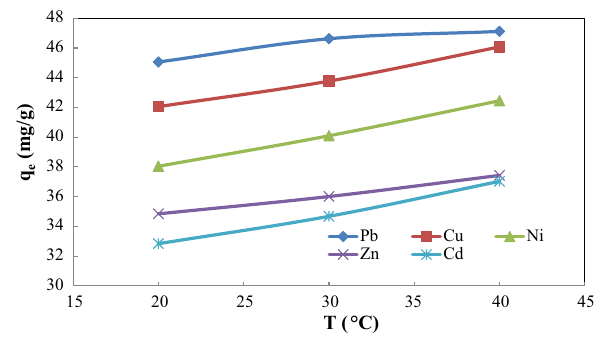
Fig. 8 Effect of temperature on the uptake of Zn(II), Ni(II), Cu(II),